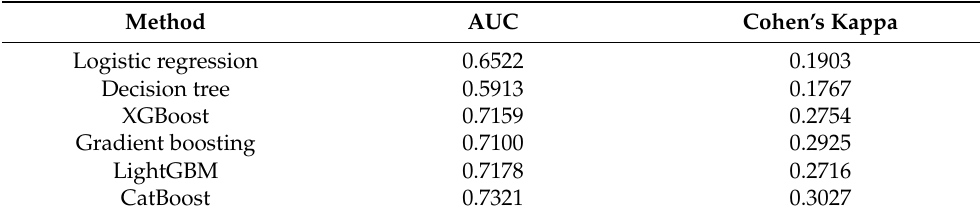
Table 14. Mean value of AUC and Cohen’s kappa coefficients for the applied supervised learning methods after a 10-fold division of the sample into a training set and a test set and running the specified method.